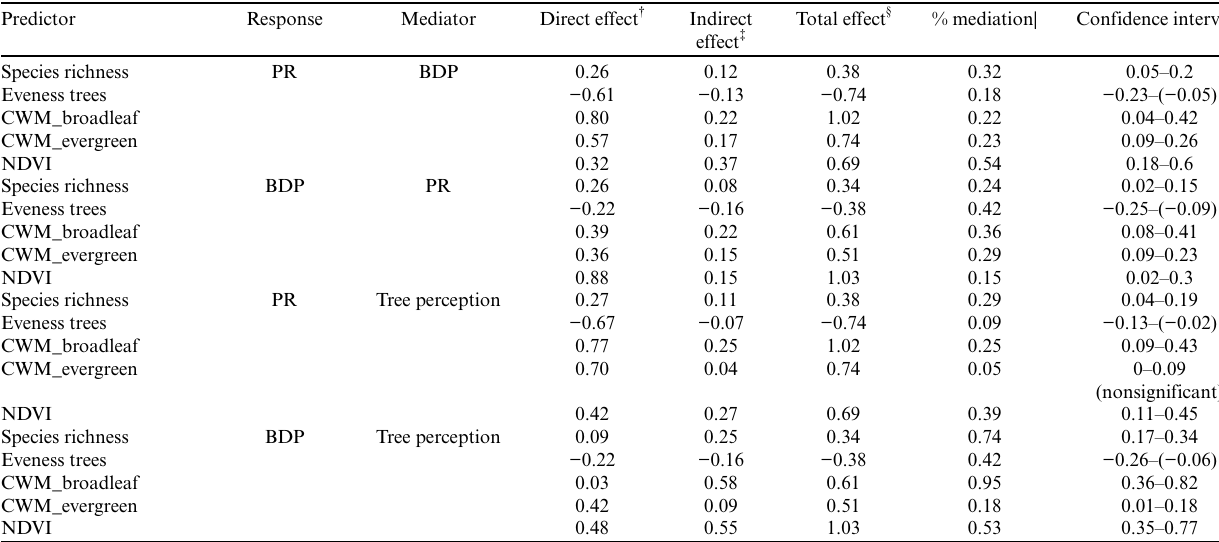
Table 6. Analysis of the mediation role of biodiversity perception (BDP) and tree diversity perception in the effect of biodiversity metrics on perceived restorativeness (PR) and of PR and tree perception on BDP. CWM_broadleaf = percentage of broadleaf species, CWM_evergreen = percentage of evergreen species, NDVI = normalized difference vegetation index (a measure of